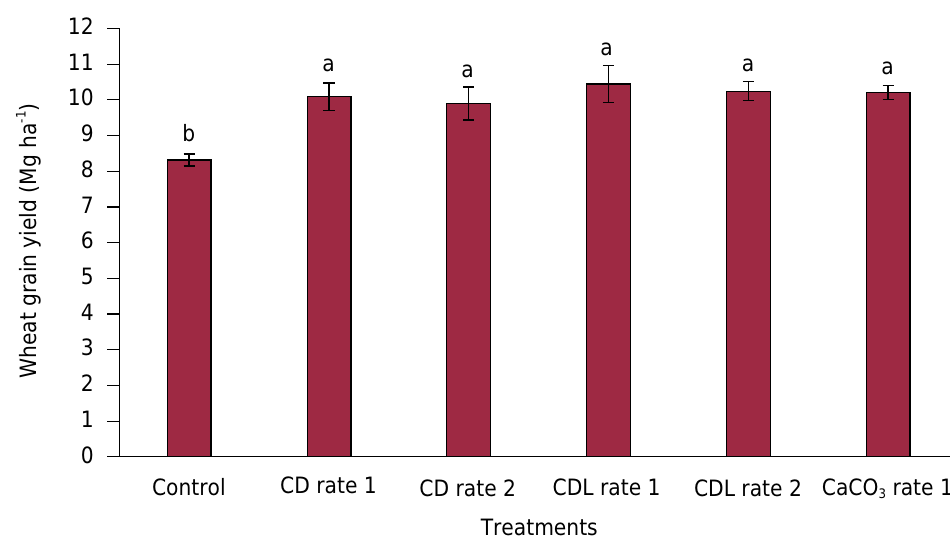
Figure 1. Wheat grain yield at Chillán in response to six treatments of soil acidity control. Different letters over the bars indicate differences between treatments according to Tukey’s test (p<0.05). Lines over the bars indicate standard error. AD: boiler ash + dregs; ADS: boiler ash + dregs + lime sludge; Rate 1: CaCO 3 reference rate; Rate 2: 2 × rate 1.